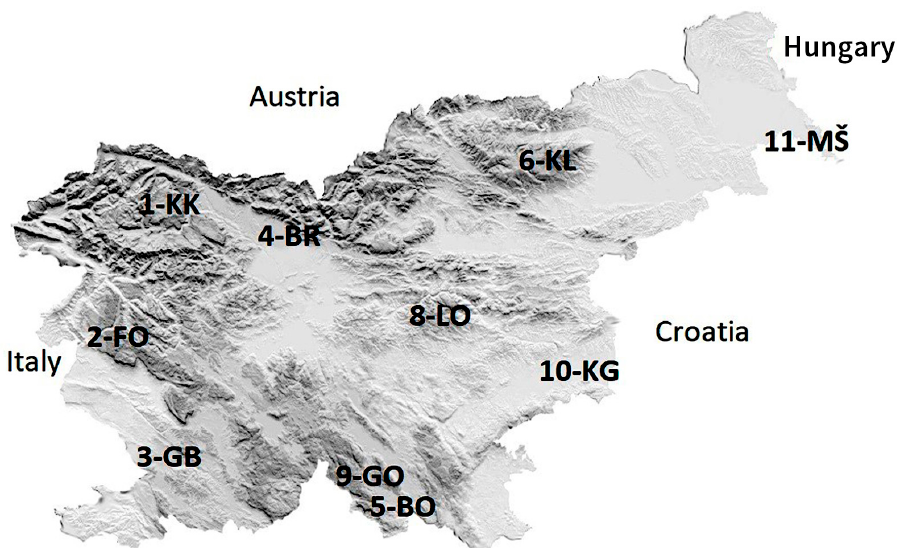
Figure 1. Locations of the Intensive Monitoring (IM) sites in Slovenia: 1-KK—Krucmanove konte, 2-FO—Fondek, 3-GB—Gropajski bori, 4-BR—Brdo, 5-BO—Borovec, 6-KL—Kladje, 8-LO—Lontovž, 9-GO—Gorica, 10-KG—Krakovski gozd, 11-MŠ—Murska šuma.